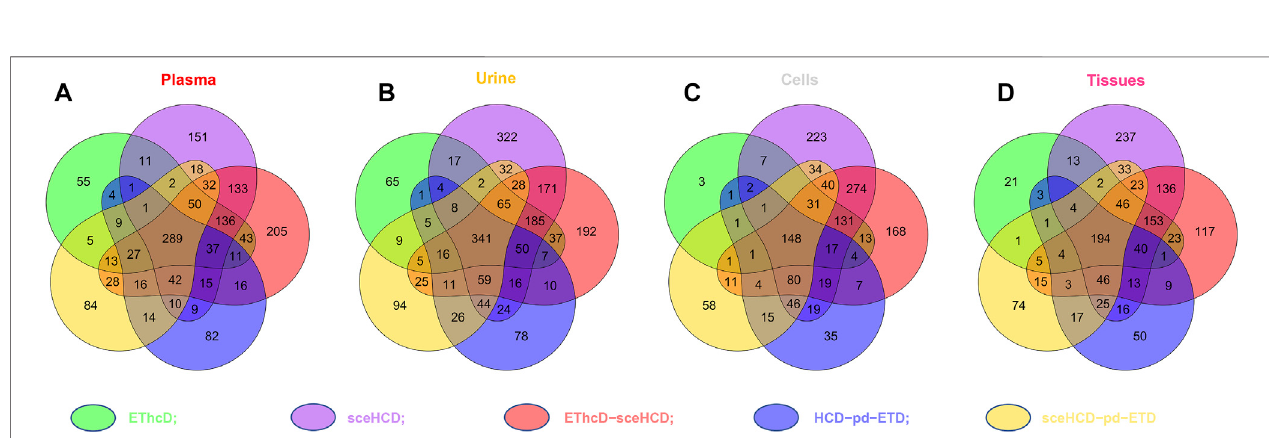
FIGURE 4 | Comparison of the intact N-glycopeptides identi fi ed by different tandem mass spectrometry (MS/MS) fragmentation modes.